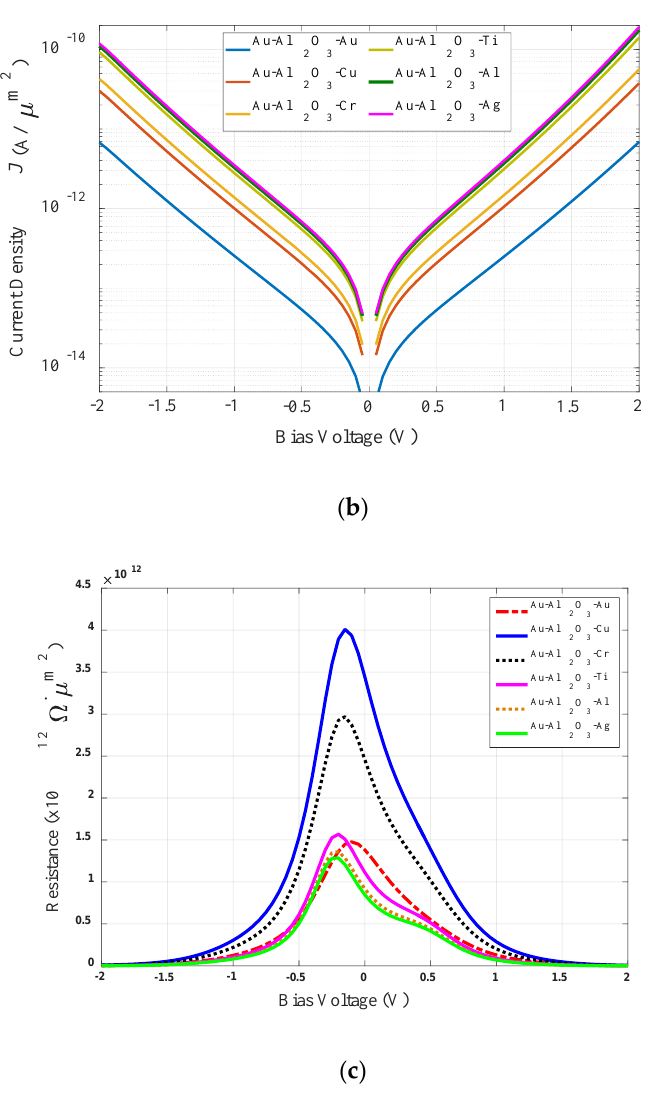
Figure 5. Variations in ( a ) the induced electric field, ( b ) the current-voltage characteristics, and ( c ) the resistance characteristics with the different material configurations of the MIM- diode.